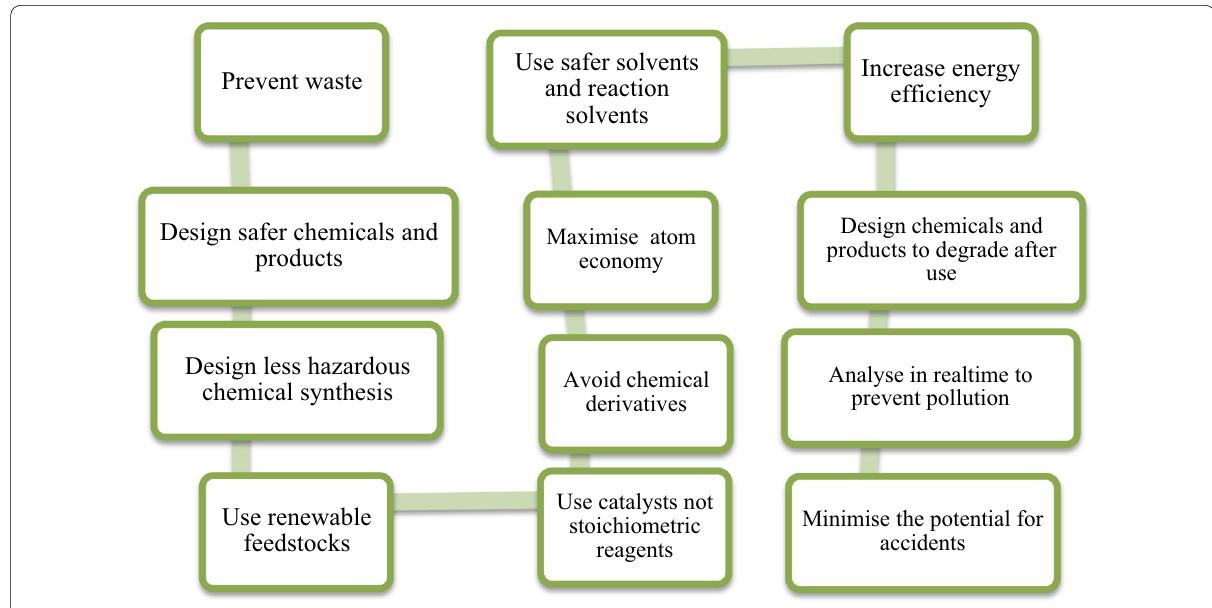
Fig. 1 Green chemistry is framed upon 12 cardinal principles’ that act as the secret essence of green nanotechnology (Schmidt